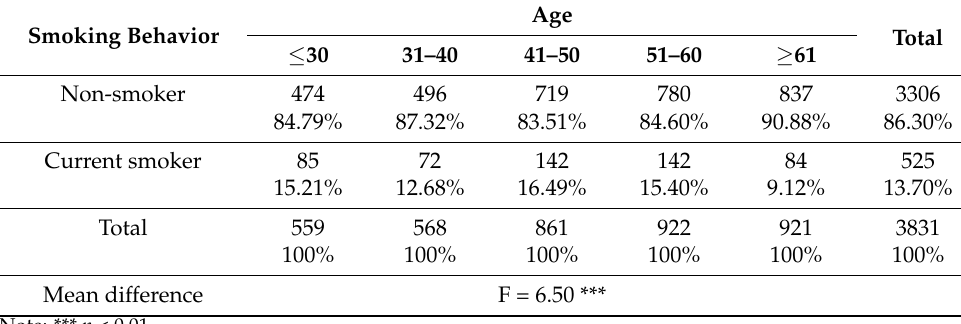
Table 3. Distribution of smoking behavior by age group.